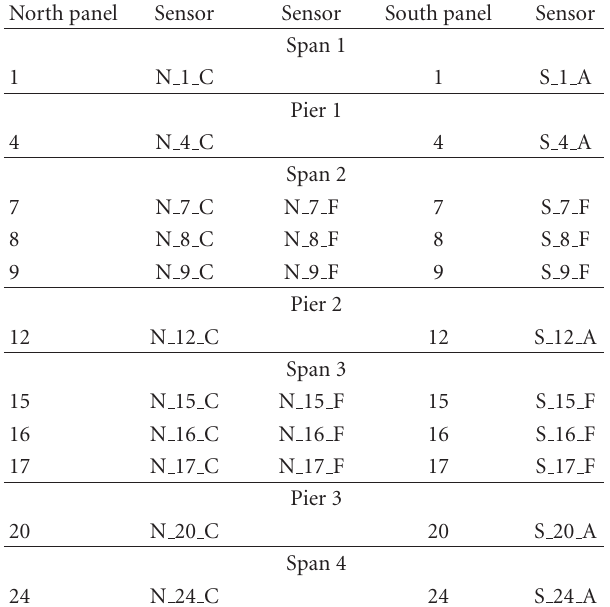
Table 2: Sensors used for longitudinal load stress monitoring (Group